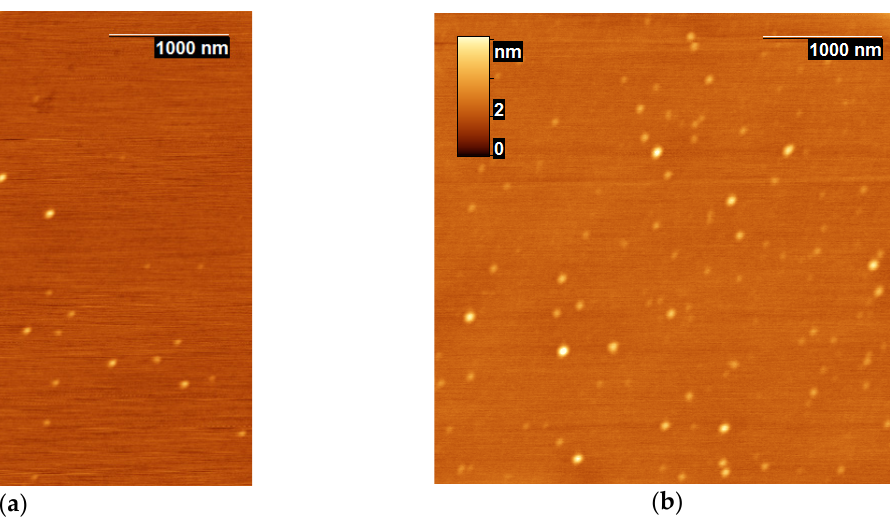
( b ) Figure 2. Height distribution of nanoparticles: ( a ) sample 1 obtained with heat inactivation of trypsin and ( b ) sample 2 obtained by inhibiting the enzyme with soybean trypsin inhibitor. 04 812 16 20 00 . 61 . 21 . 82 . 433 . 64 . 24 . 85 . 466 . 67 . 27 . 88 . 499 . 610 . 2 N u m b e r o f p a r t i c l es H, nm H, nm